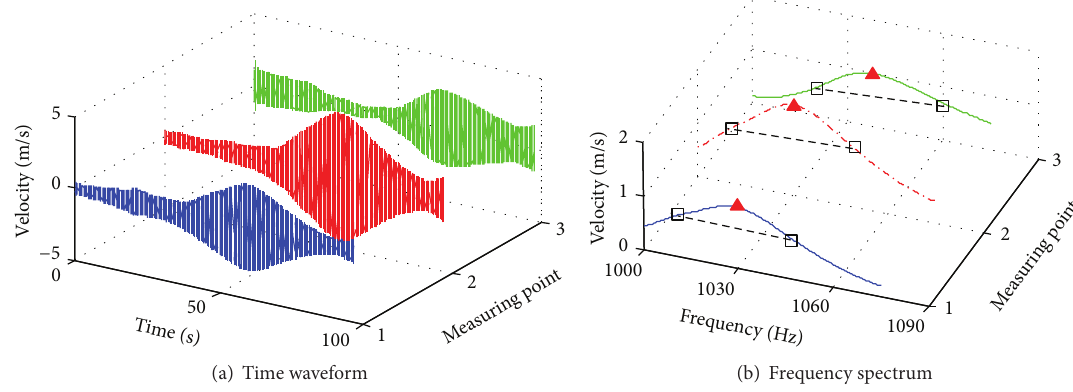
Figure 9: Time waveform and frequency spectrum for the third natural frequency and damping ratio of TCS at 3 measuring